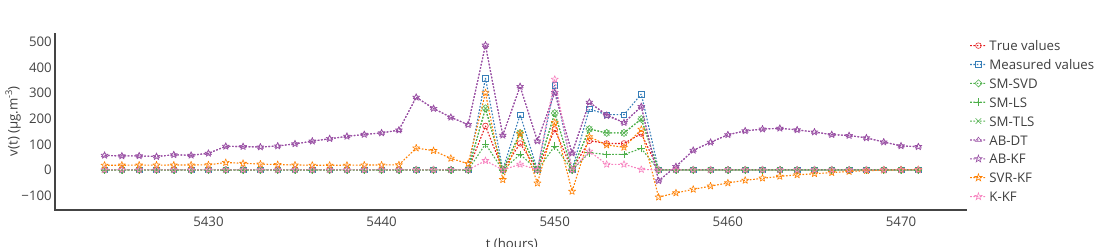
Figure 13. True values, measured values and corrected values with the strategies considered for a particular sensor between t = 5424h and t = 5471h with the Gaussian plume model. Note that the profiles of the curves are very different from those of Figure 6 as instruments are not necessarily exposed to the plume of pollutant due to the wind direction. In this case it is exposed to the pollutant between t = 5445h and t = 5456h.